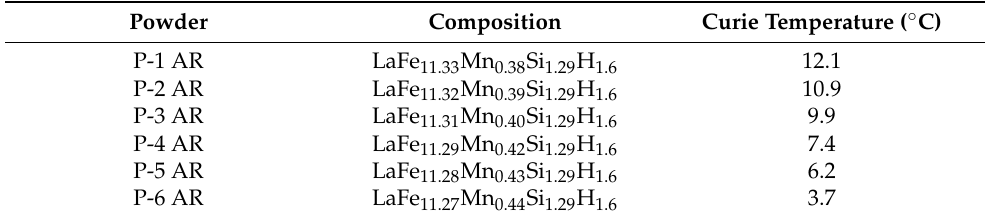
Figure 1. Optical imaging of ball milled (30 min) magnetocaloric powders ( a ) P-1 M, ( b ) P-2 M, ( c ) P-3 M, ( d ) P-4 M, ( e ) P-5 M, and ( f ) P-6 M. Table 1. Composition and Curie temperature for the investigated magnetocaloric powders P-1 AR–P-6 AR.